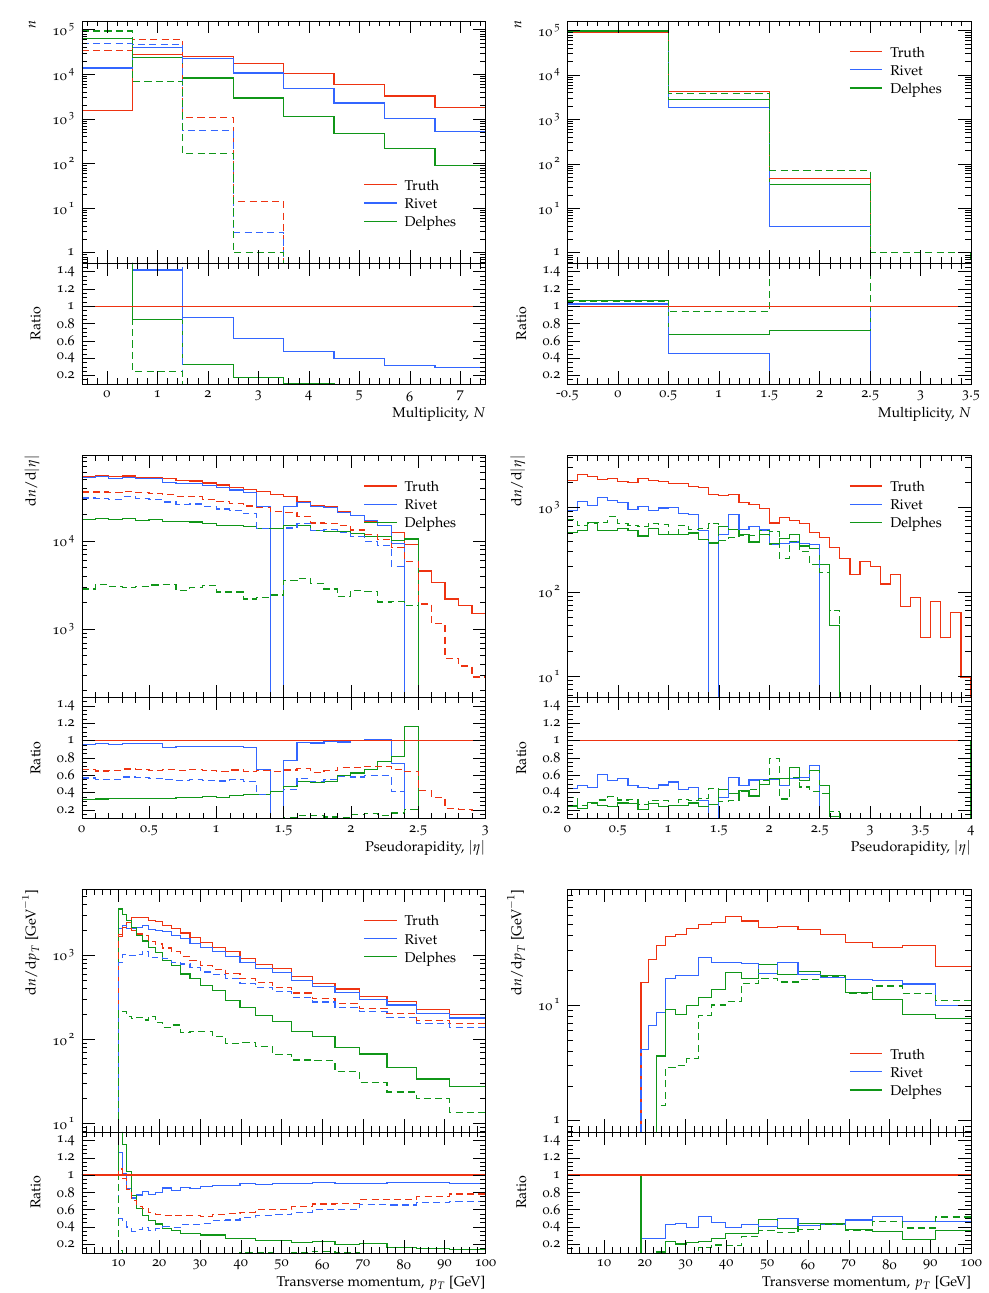
Figure 4: Photon and tau performance from MG5 + Pythia8 LHC t ¯ t γ production at truth level, and after processing through the standard ATLAS detector emulation routines in R IVET and D ELPHES . Photon observables are shown in the left column, and tau one in the right. The observables shown are multiplicity, p distribution from top to